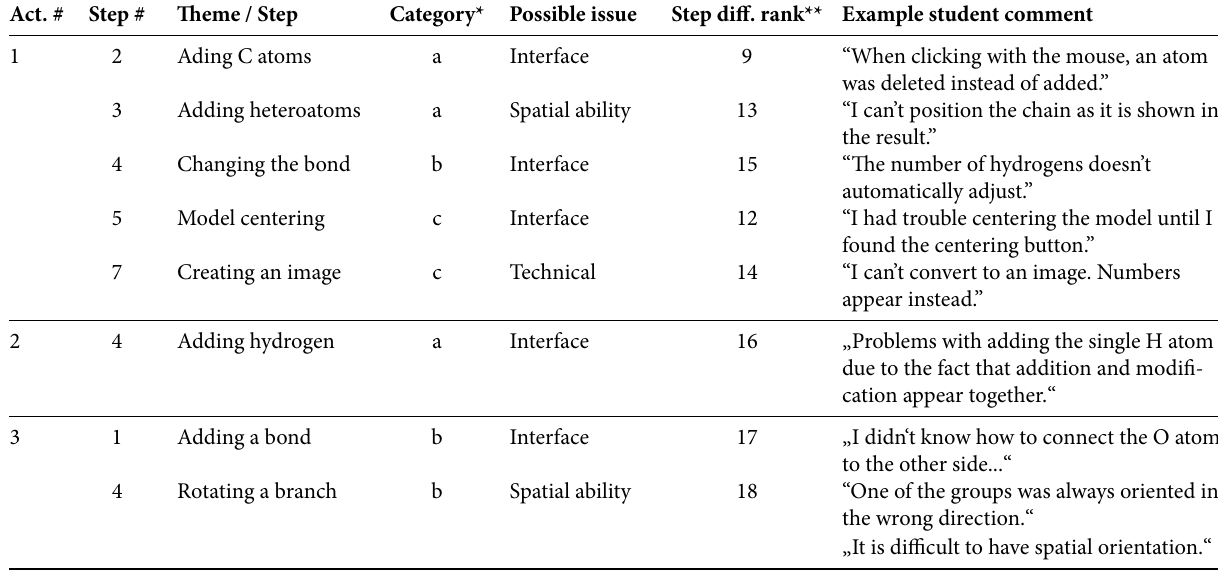
Table 9: Summary of the most frequent difficulties with example student comments Act. # Step